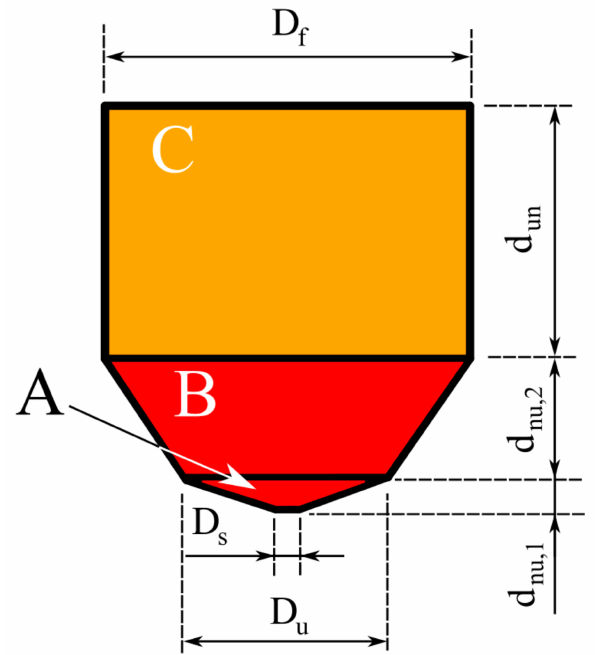
Figure 12. Schematic view of the three regions defined to calculate the pressure drop in the granular bed. Flow is non-uniform in zones A and B (red) and uniform in zone C (orange). See text for definitions of the